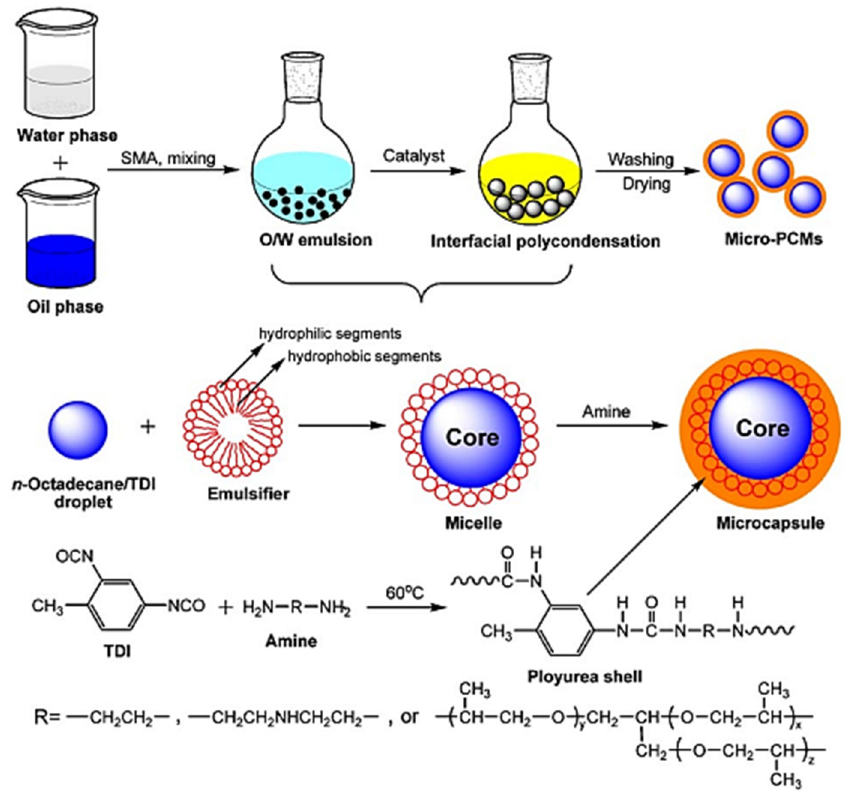
Figure 51. Schematic formation of the microencapsulated n-octadecane with the polyurea shells containing different soft segments through interfacial polycondensation. From reference [77].